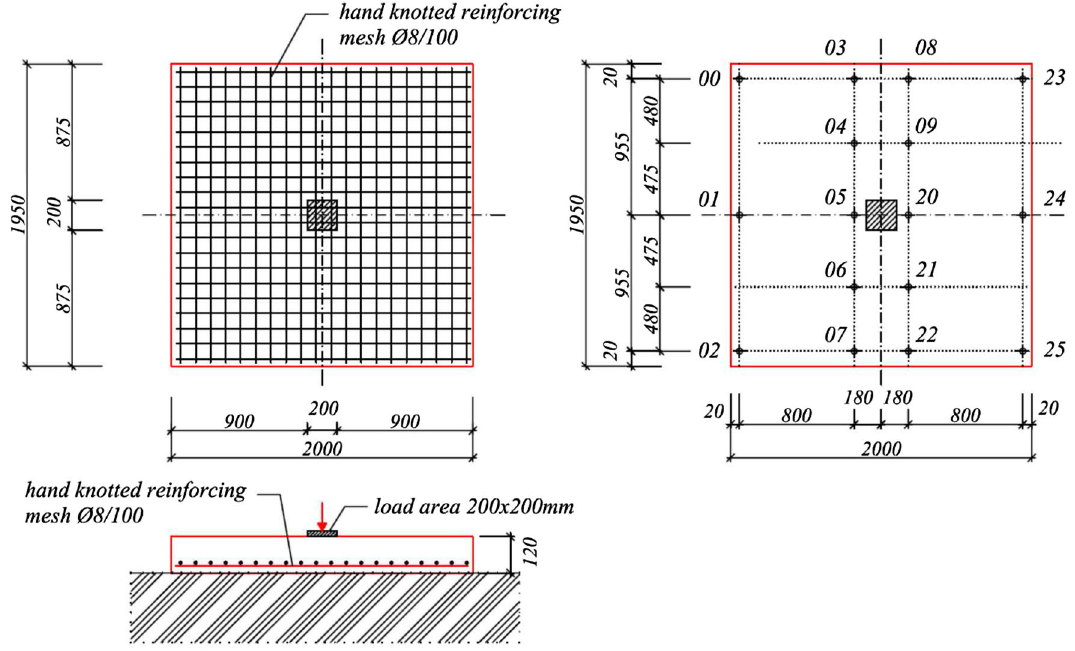
Fig. 2 The test sample and placement of deformation sensors